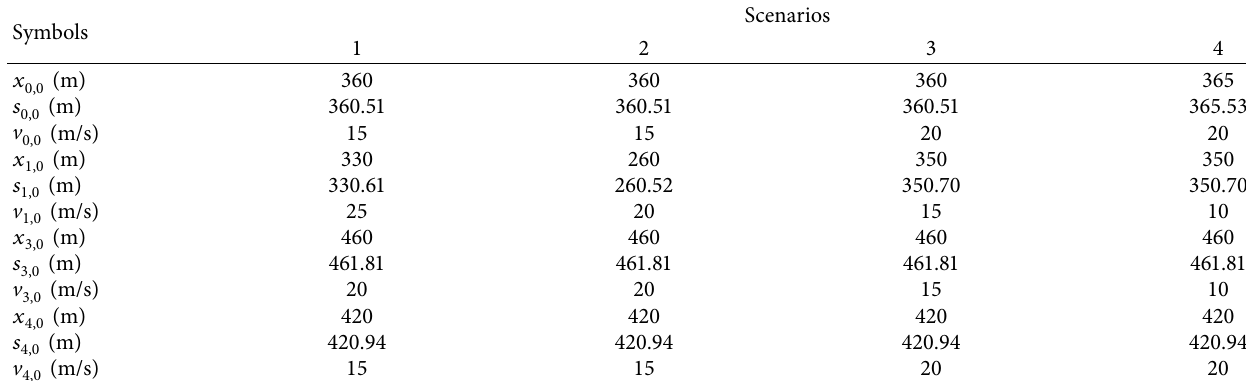
Figure 8: Relationship between CPU time and headways. Table 4: Test scenarios for trajectory planning.